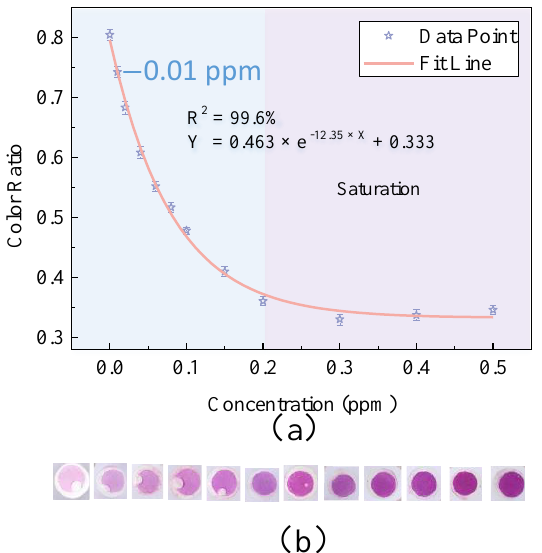
Table 1. A comparison of the AHMT-based methods for formaldehyde determination.